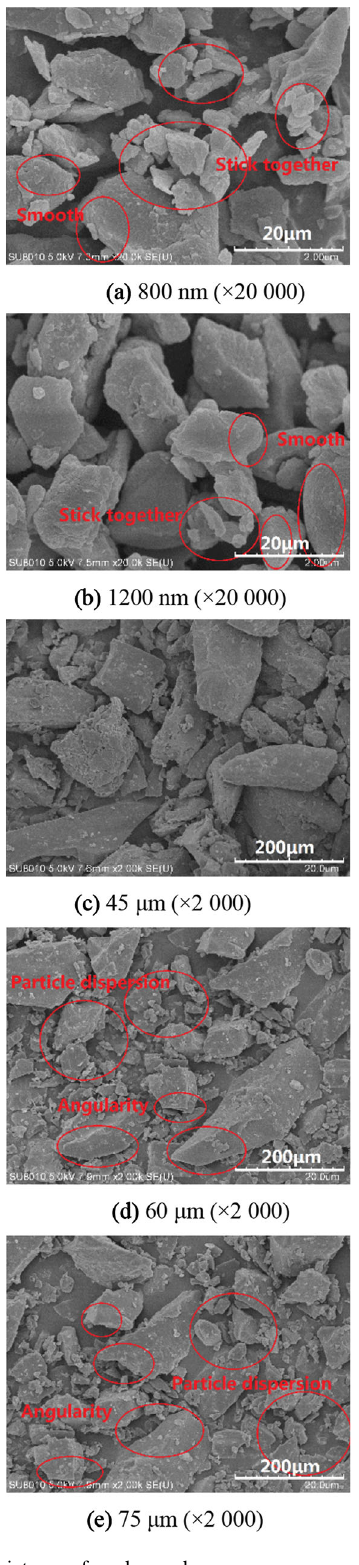
Fig. 1 SEM pictures of coal